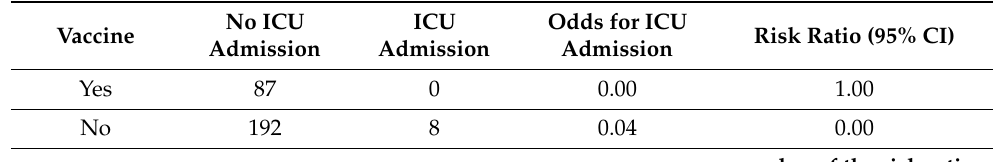
p -value of the risk ratio comparison